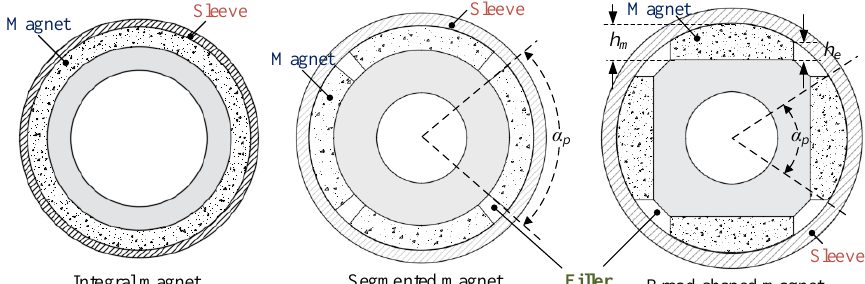
Figure 2. Different SPM rotor